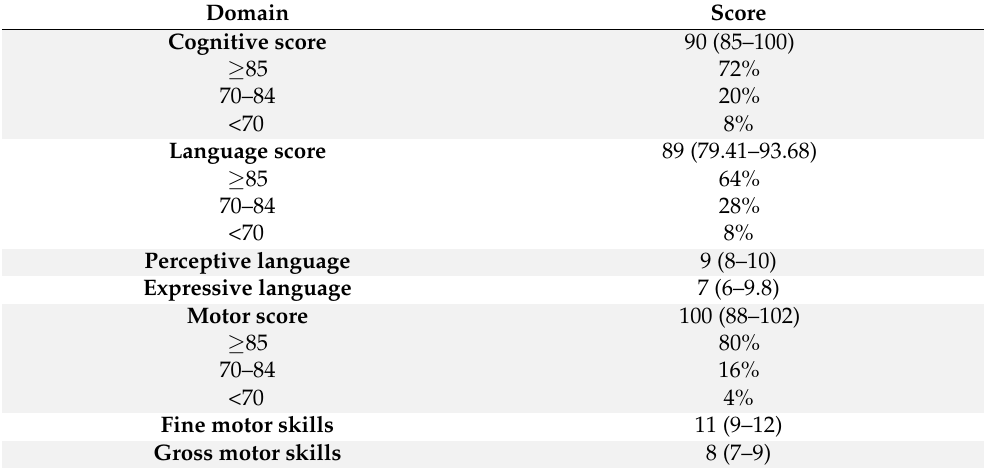
Table 3. Neurodevelopmental outcomes using the Bayley scales of infant and toddler development (Bayley-III).